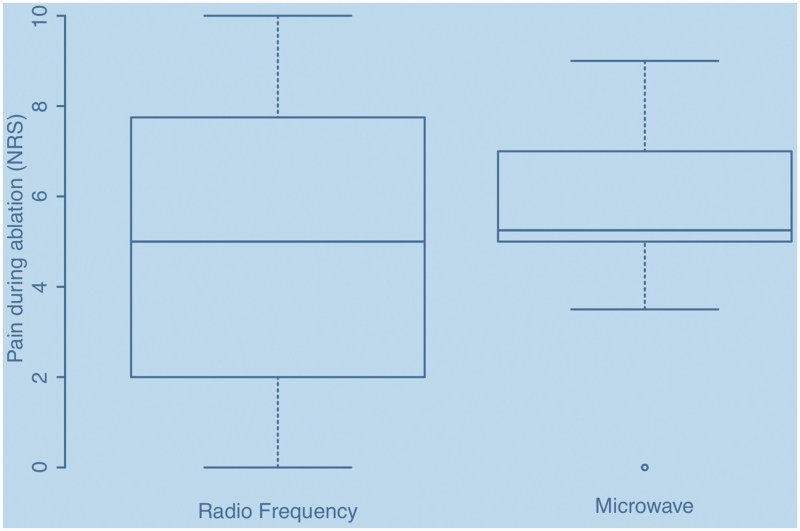
Pain median radio frequency ablation (5, IQR 2–7.4) versus microwave ablation (5, IQR 4.25–6.75).